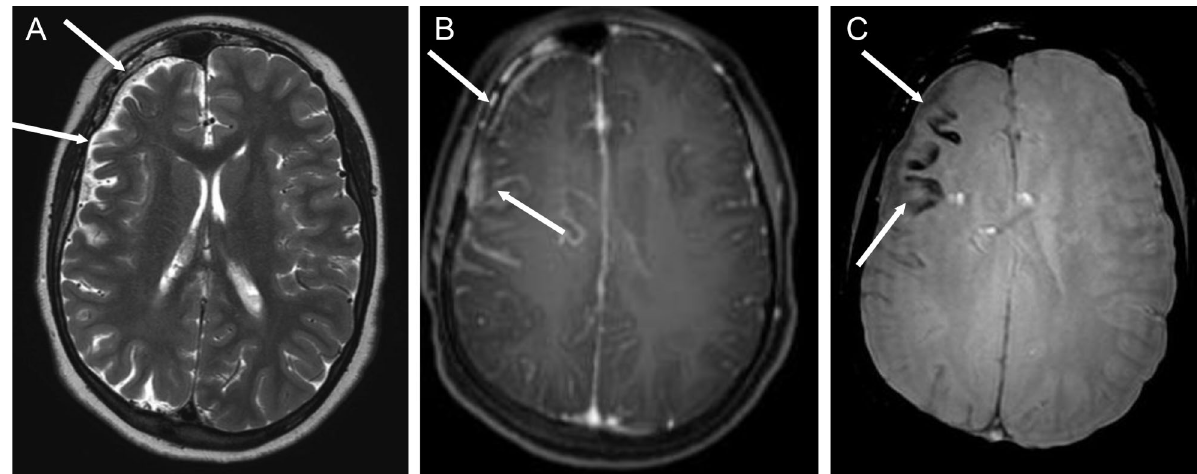
Figure 9 - Sturge-Weber syndrome in a 14-year-old boy with multiple epileptic foci in the right cerebral hemisphere (video-EEG) and chronic partial epilepsy. A) An axial T2-weighted image showing right cerebral hemiatrophy (white arrows). B) An axial T1-weighted sequence after gadolinium injection, demonstrating leptomeningeal enhancement of the fronto-parietal region (white arrows). C) Axial SWI revealing cortical calcification in the frontal lobe, appearing as signal voids (white